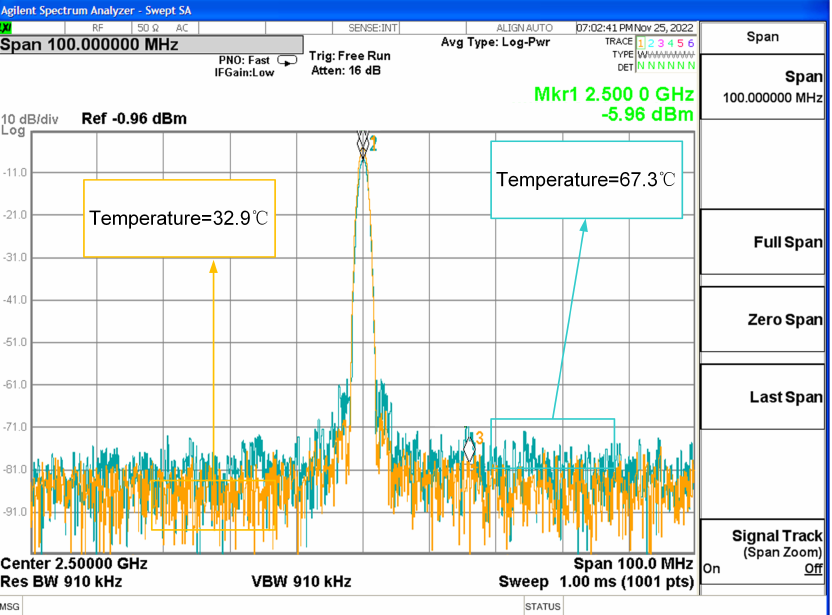
Figure 17. Spectrum of proposed FNPLL at different temperatures.